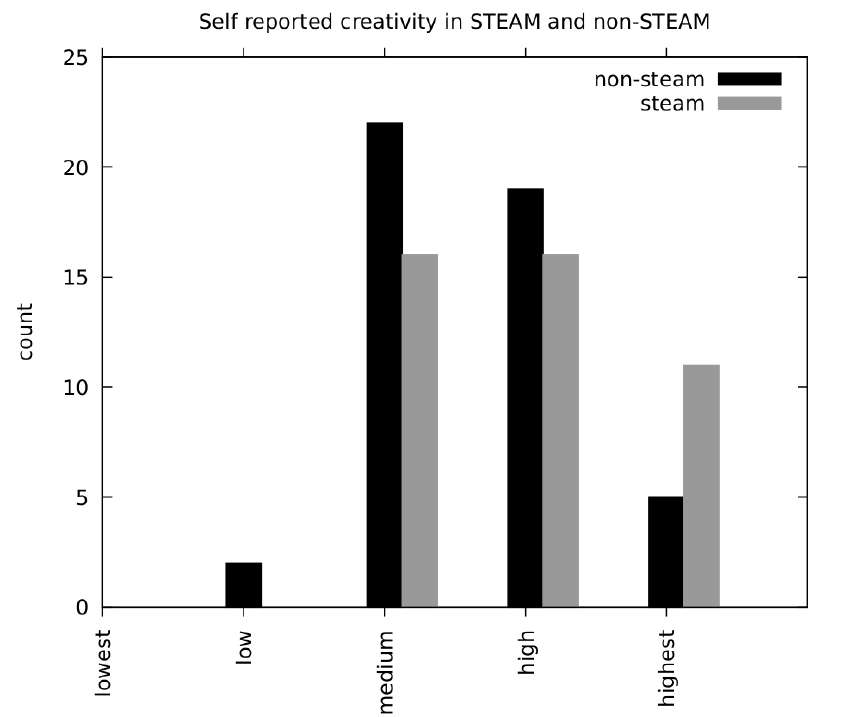
Fig. 4. Histogram of the two distributions of self reported creativity, showing the tendency for students to report higher levels of creativity in